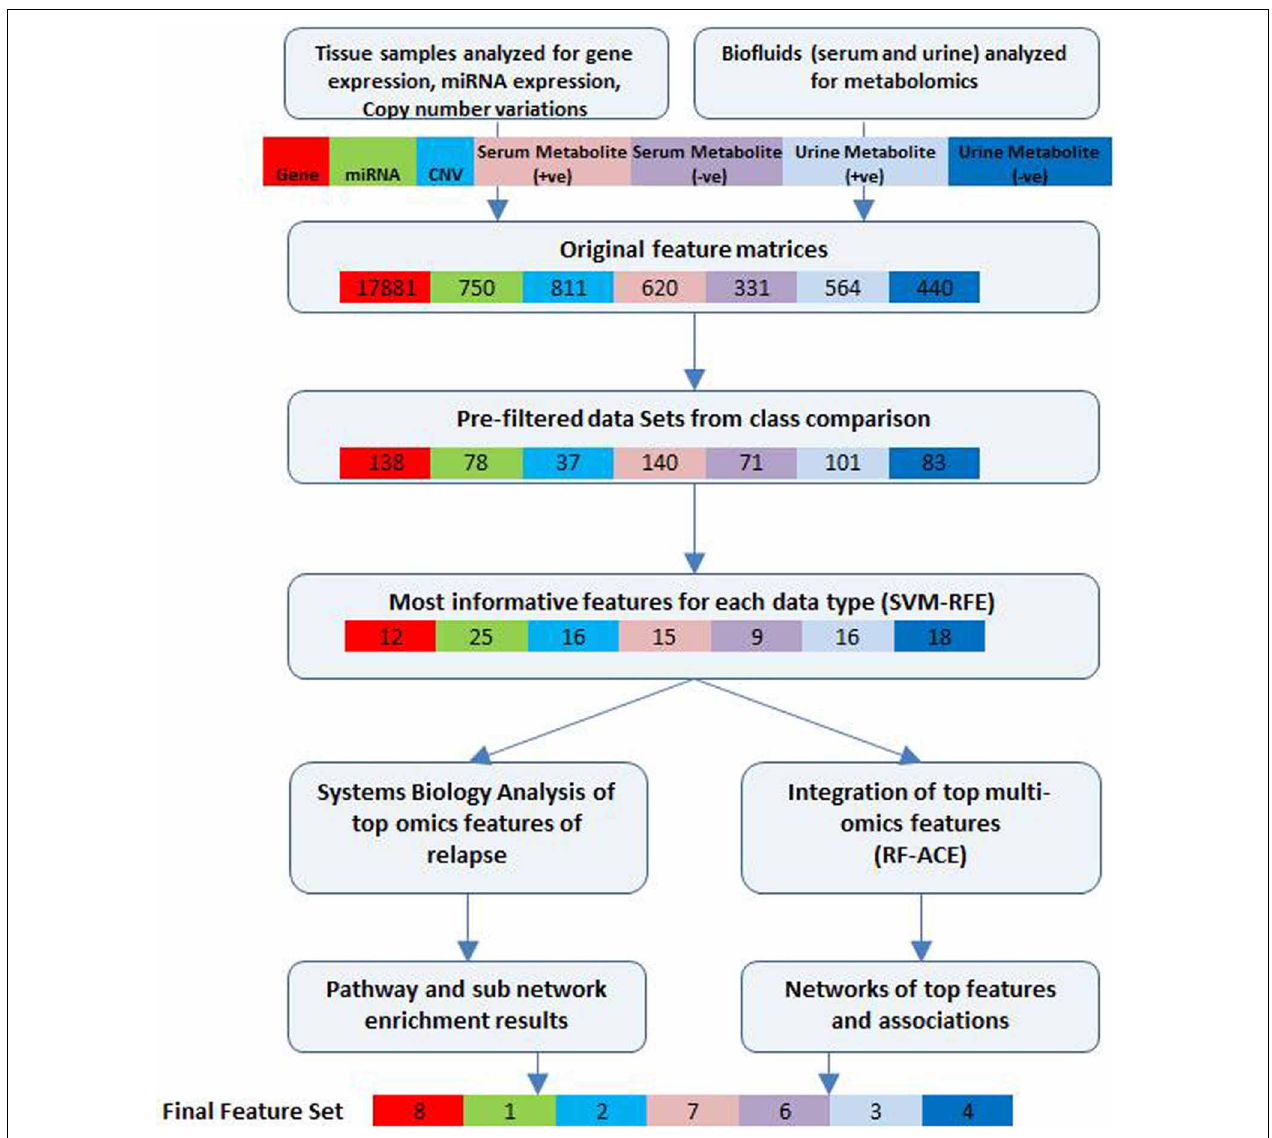
FIGURE 1 | Bioinformatics workflow of multivariate analysis. Feature selection workflow for multi-omics profiling data from colorectal cancer patient samples (for relapse outcome) shown. Feature numbers for each data